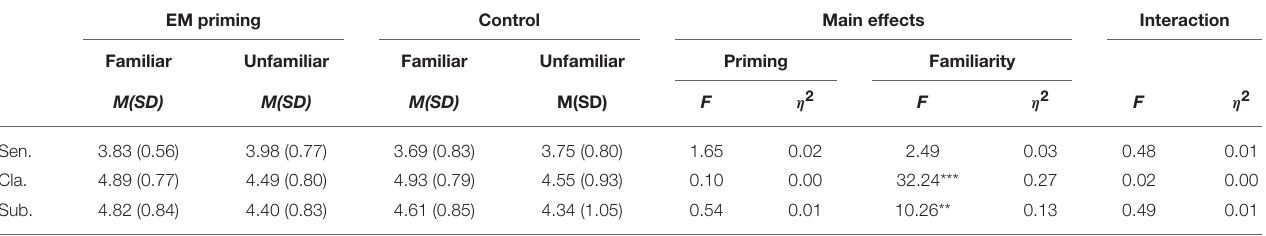
TABLE 2 | Phenomenal characteristics between familiarity and priming conditions. EM priming Control